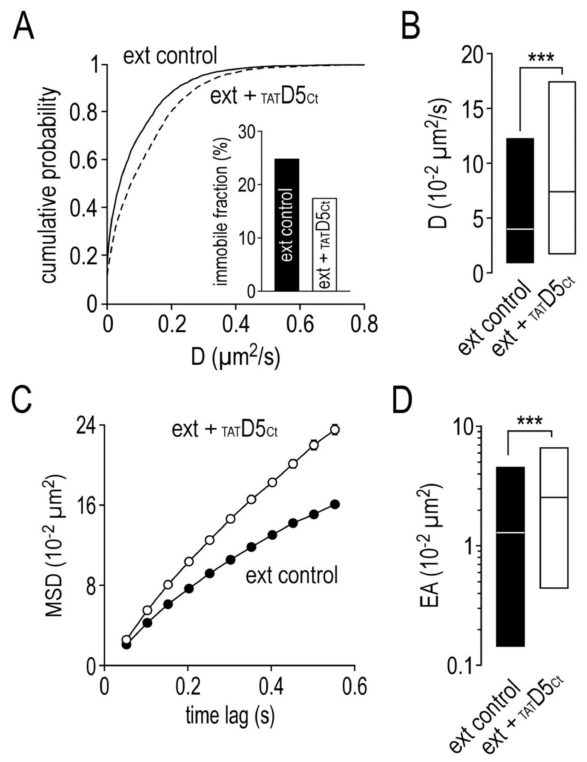
Figure 6. The disrupting peptide also affects the surface dynamic properties of extrasynaptic GABA A receptors. ( A ) Cumulative probability diffusion coefficient of extrasynaptic GABA A receptors in control condition or in the presence of the disrupting peptide (10 µ M). The inset shows the immobile fraction (defined as D < 0.005 µ m 2 /s) of extrasynaptic GABA A receptors in control condition and in the presence of the disrupting peptide. ( B ) Bar graphs illustrating the instantaneous diffusion coeffi- cient (D, represented as median ± interquartile range 25–75%) of extrasynaptic GABA A receptors in control condition or in the presence of the disrupting peptide. ( C ) Comparison of extrasynaptic GABA A receptors mean square displacements (MSD, represented as mean ± SEM) in control condi- tion or in the presence of the disrupting peptide. ( D ) Bar graphs illustrating the explored surface area (EA, represented as median ± interquartile range 25–75%) of extrasynaptic GABA A receptors in control condition or in the presence of the disrupting peptide. *** p < 0.001.